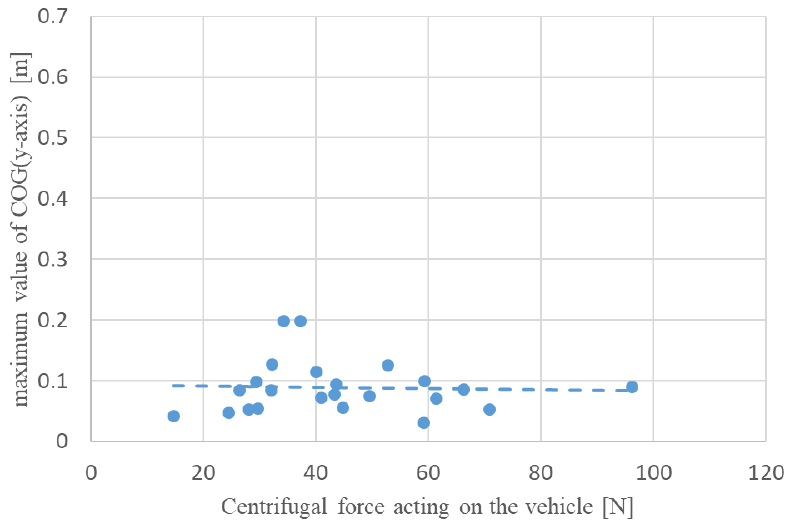
Figure 9. Relationship between the maximum value of COG ( y -axis) and centrifugal force on the vehicle during manual turning.